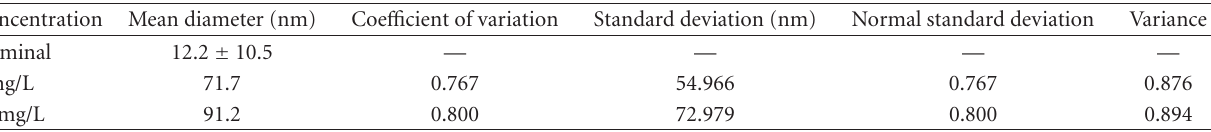
Table 2: Size distribution of Ag-NPs measured using DLS.